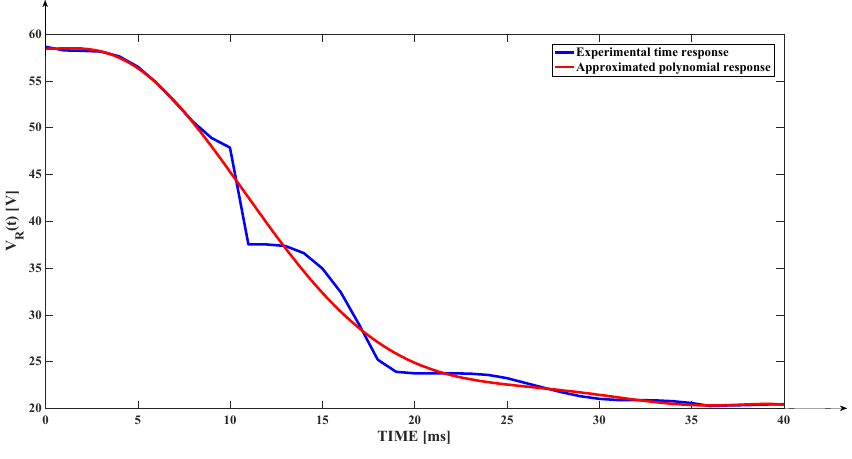
Figure 3. Approximated polynomial response.